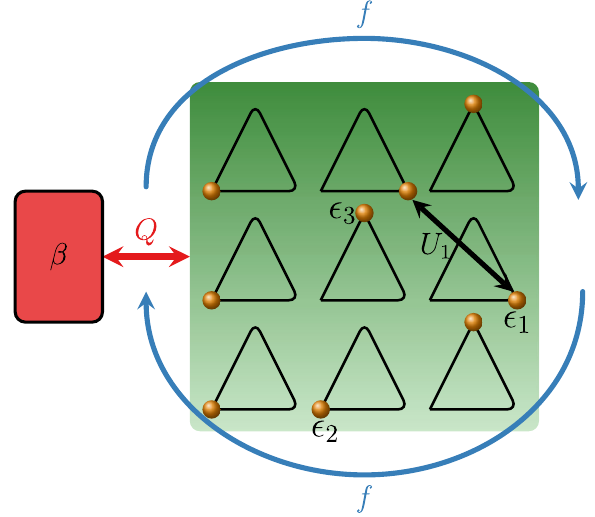
FIG. 1. Small network of identical and all-to-all interacting three-state units in contact with a heat bath β and in the presence of a nonconservative force f